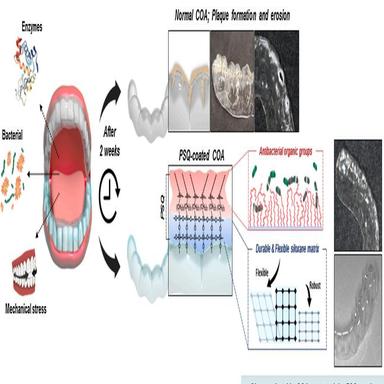
Schematic illustration showing strategy and effects of PSQ coating to overcome problems of COA used for 2 weeks in harsh oral environment.